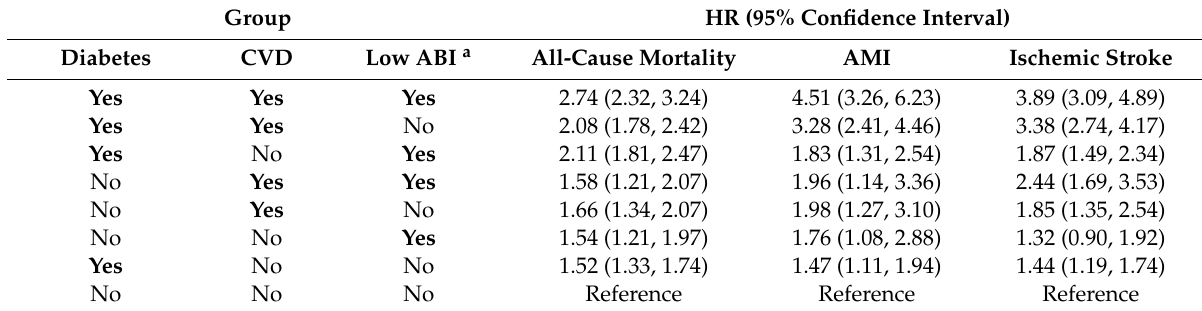
Table A7. Adjusted hazard ratios (95% confidence intervals) for all-cause mortality, acute myocardial infarction, and ischemic stroke, by groups. Complete cases. Group HR (95% Confidence Interval) Diabetes CVD Low ABI a All-Cause Mortality AMI Ischemic